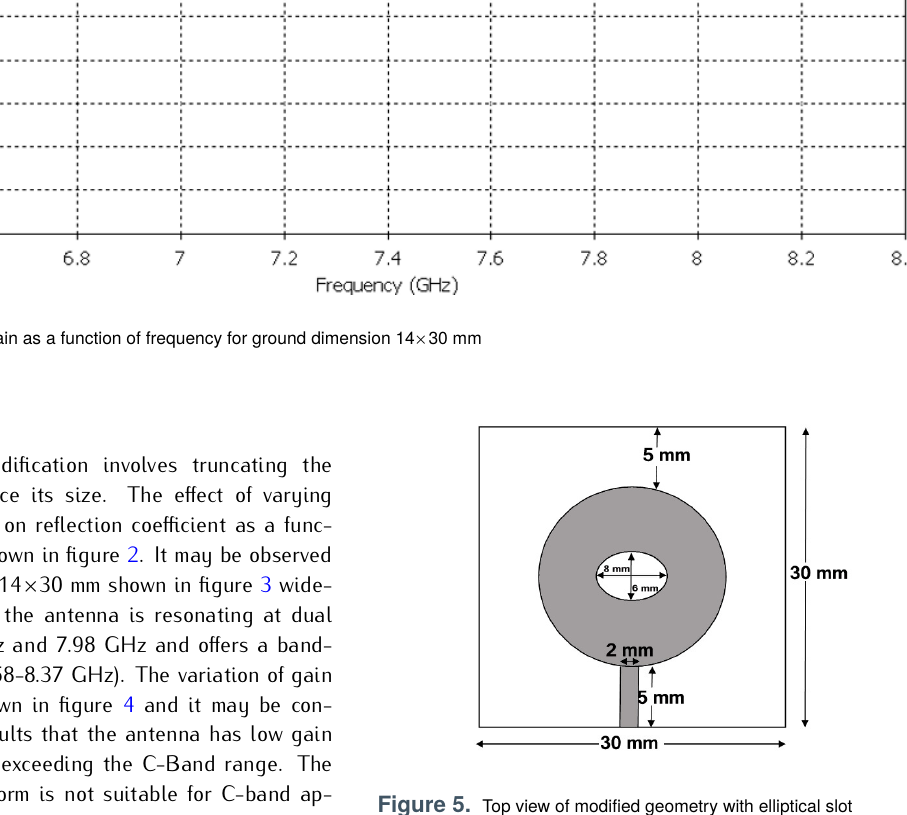
Figure 5. Top view of modified geometry with elliptical